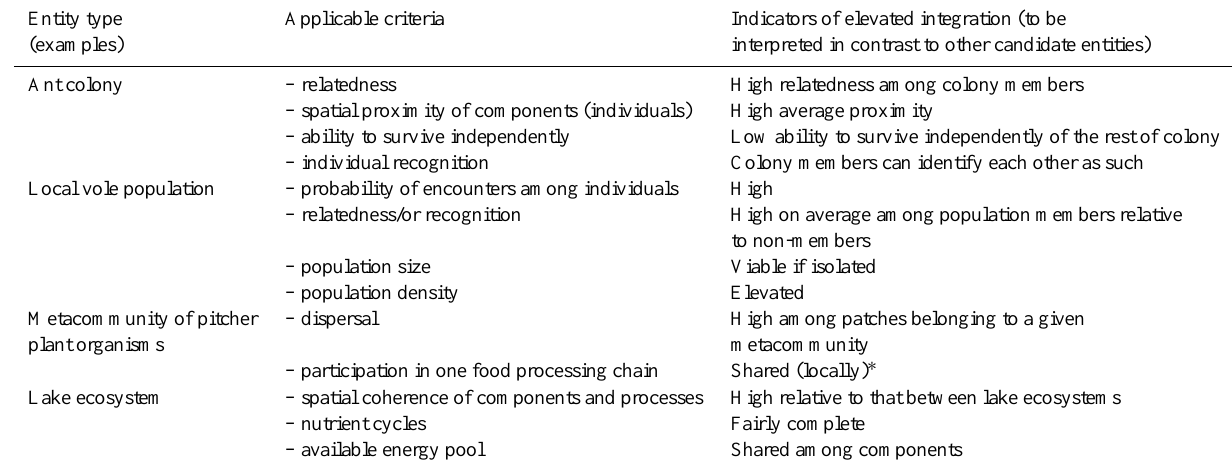
Table 1. Entities and possible criteria that could be used in defining them (examples). The criteria here are for the sake of argument rather than supplying a particular area of research with solutions. They aim to show that entities can be defined without employing the concept of boundary even if boundaries, once determined, may be useful in identifying